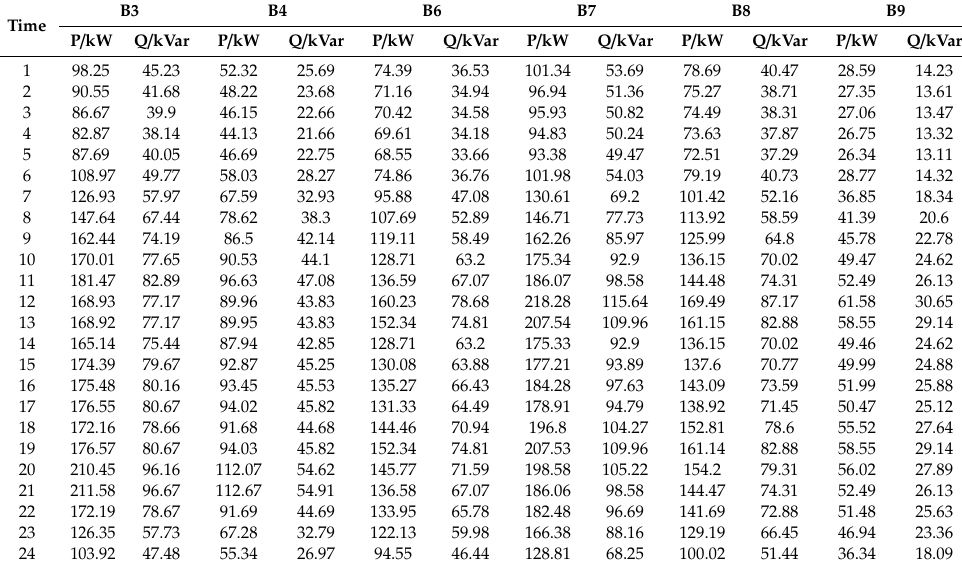
Table A1. The bus load at di ff erent time of nodes 3–9.